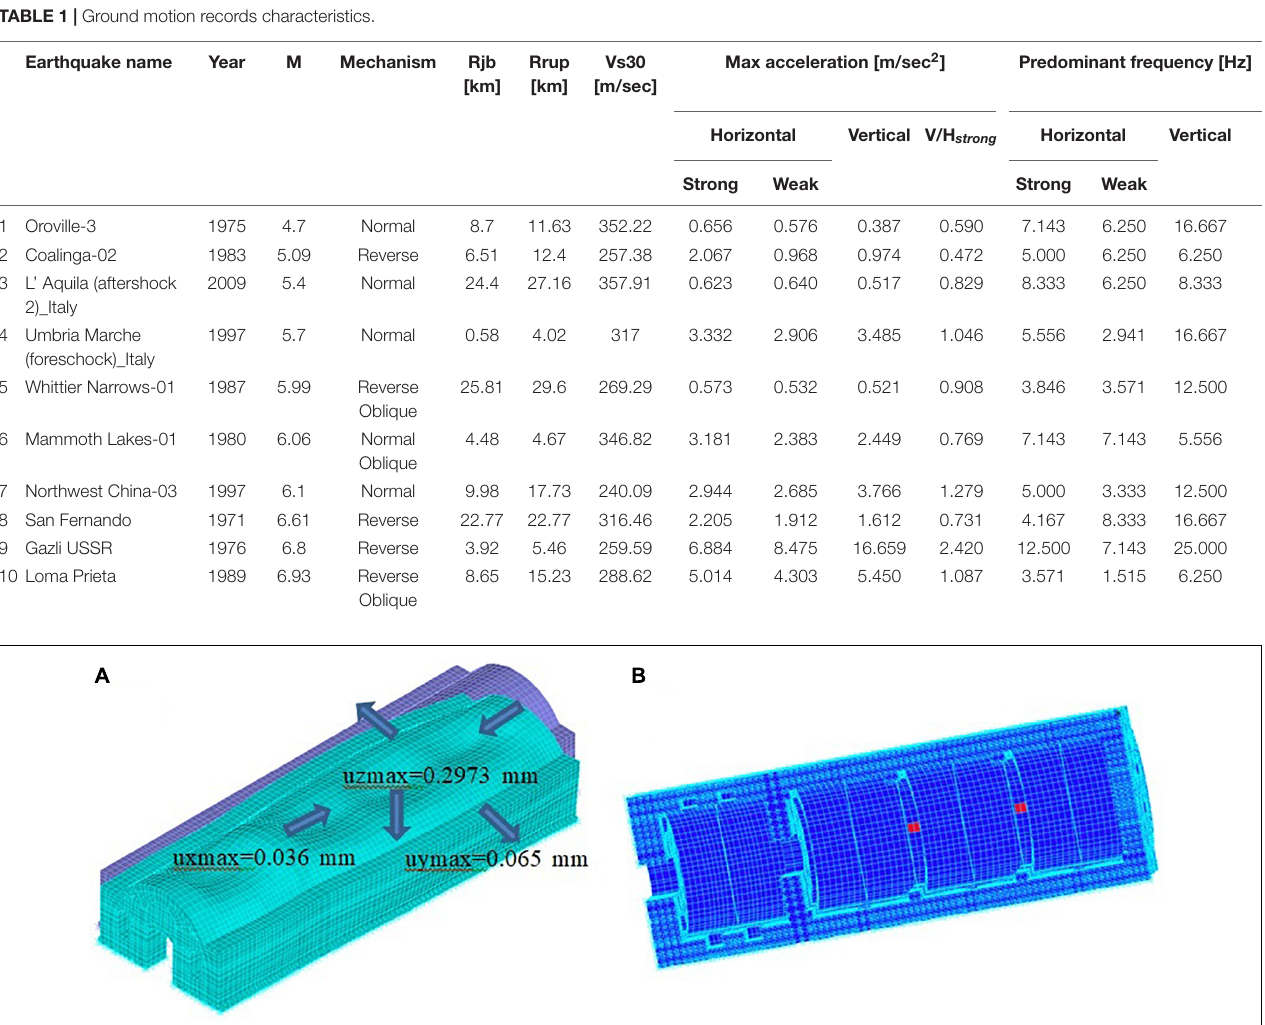
FIGURE 4 | (A) Maximum displacements. (B) Generated